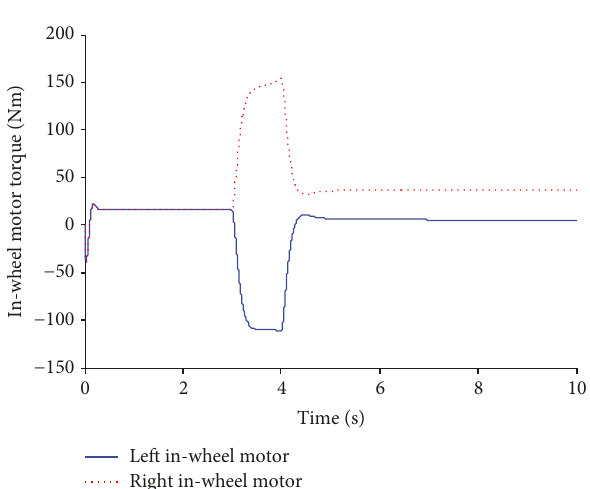
Figure 13: Left and right in-wheel motor